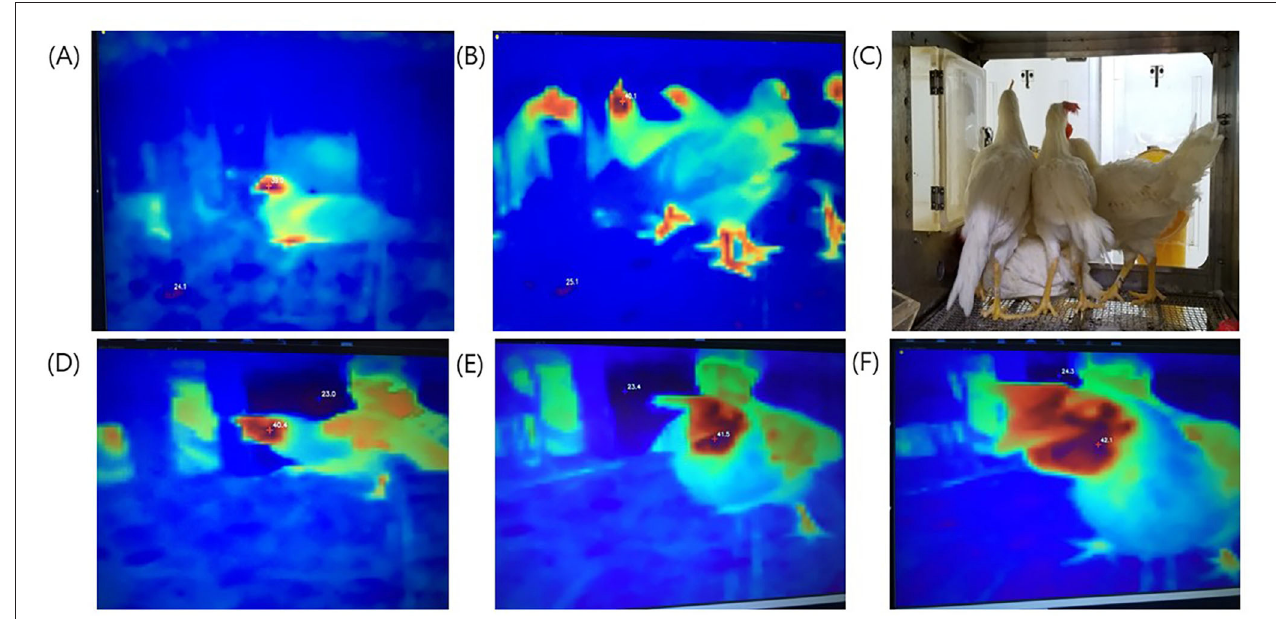
FIGURE 1 | Thermal images taken from different experimental set-ups. Top photos (A–C) : Temperature measurement site of one chicken or several chickens compared to the actual photographs. (A) One chicken; (B) several chickens; (C) actual photo. Bottom photos (D–F) : Differences in temperature measurement relative to distance. The shorter the distance, the higher was the measured temperature. (D) long distance, 40.4 ◦ C; (E) intermediate distance, 41.5 ◦ C; (F) short distance 42.1 ◦